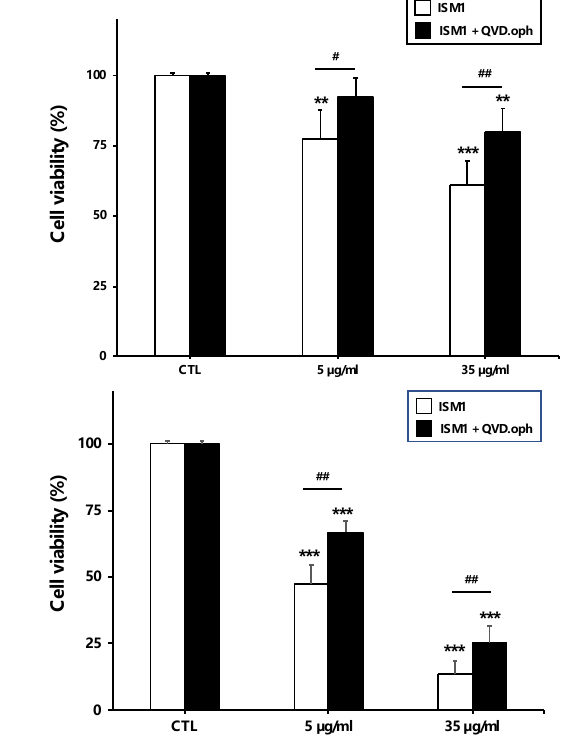
Figure 5. Recombinant ISM1 decreased podocyte viability . ( a ) Staining with phalloidin-FITC showed that the F-actin cytoskeleton was disorganized after strong stimuli with ISM1 in podocytes. Synaptopodin (SYNPO) lost its co-localization with actin upon addition of high concentrations of ISM1 to podocytes. ( b ) Podocytes were treated with recombinant ISM1 (5 and 35 µ g/mL) for 24, 48, and 72 h. ISM1 significantly decreased the podocyte viability. ***, p < 0.001 vs CTL. ( c , d ) Podocytes were treated with ISM1 (5 and 35 µ g/mL) for 24 and 72 h in the presence or absence of QVD-oph, a pan-caspase inhibitor. QVD-oph prevented ISM1-induced decrease in viability under mild conditions (5 µ g/mL, 24 h) ( c ). At higher doses or longer incubations of ISM1, QVD-oph only partially inhibited podocyte mortality ( d ). **, p < 0.01 vs. CTL ***, p < 0.001 vs CTL; ##, p < 0.01 treated vs untreated QVD, #, p < 0.05 treated vs untreated QVD. Bars = 20 µ m for CTR and 24h and 50 µ m for 72h. On the other hand, the addition of recombinant ISM1 to podocytes induced a dose- and time-dependent decrease in their viability (Figure 5b). This ISM1 toxicity was significantly reduced after the addition of QVD-oph, a pancaspase inhibitor (Figure 5c). Thus,